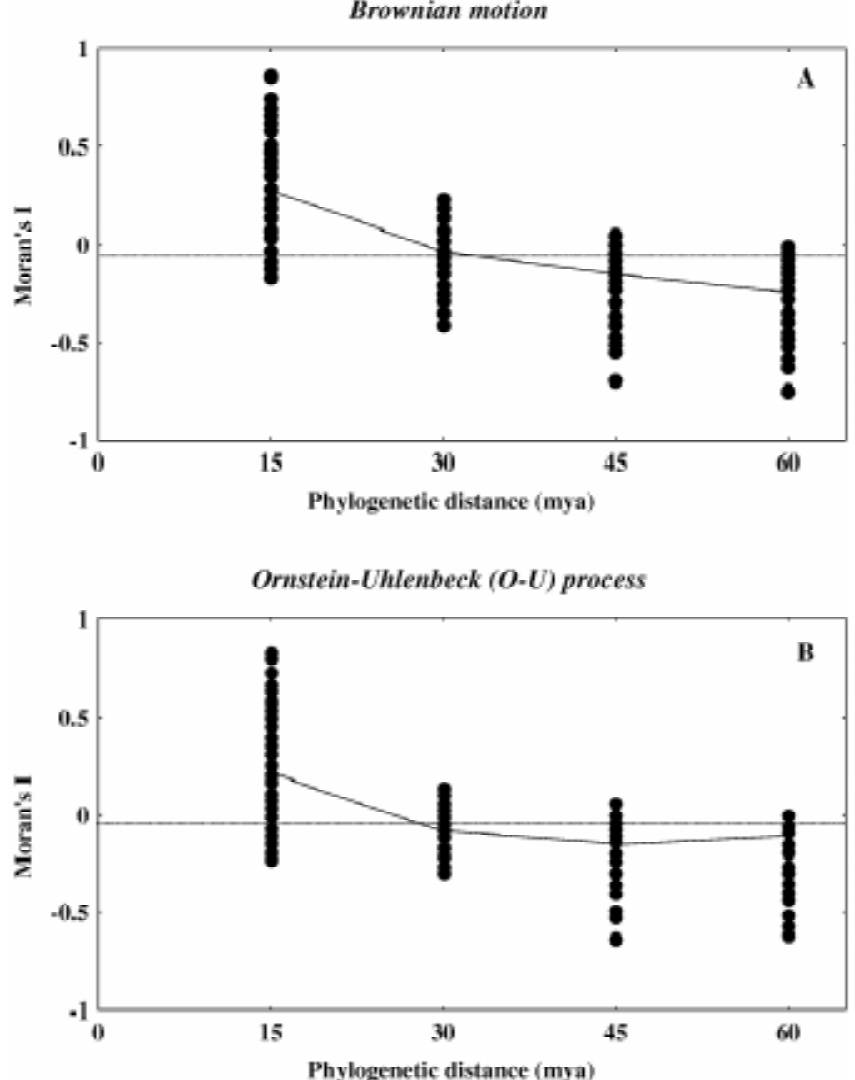
Figure 3 - Phylogenetic correlograms obtained by simulations of Brownian motion (A) and Ornstein-Uhlenbeck (O-U) (B) processes, on the phylogeny of 19 species of South American owls. Dashed lines indicate the expected value under the null hypothesis of no autocorrelation, and full lines indicate the average